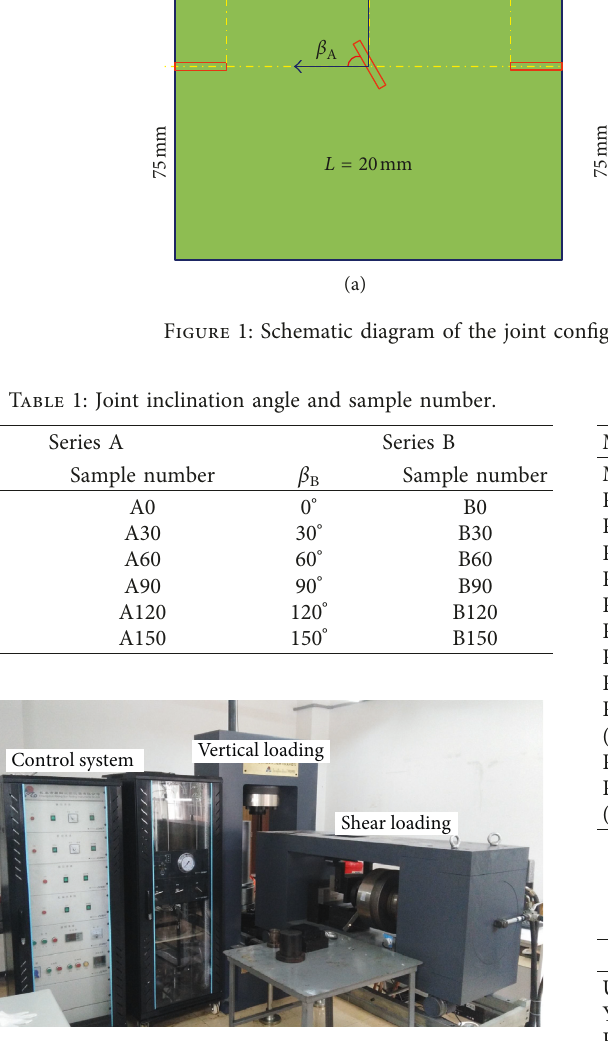
Figure 2: Testing instrument.